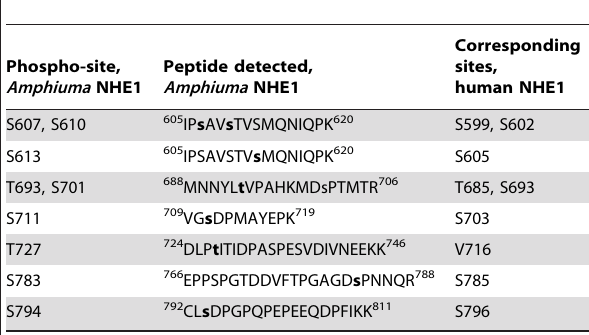
Table 3. NHE1 phosphorylation sites detected in situ in at RBCs by